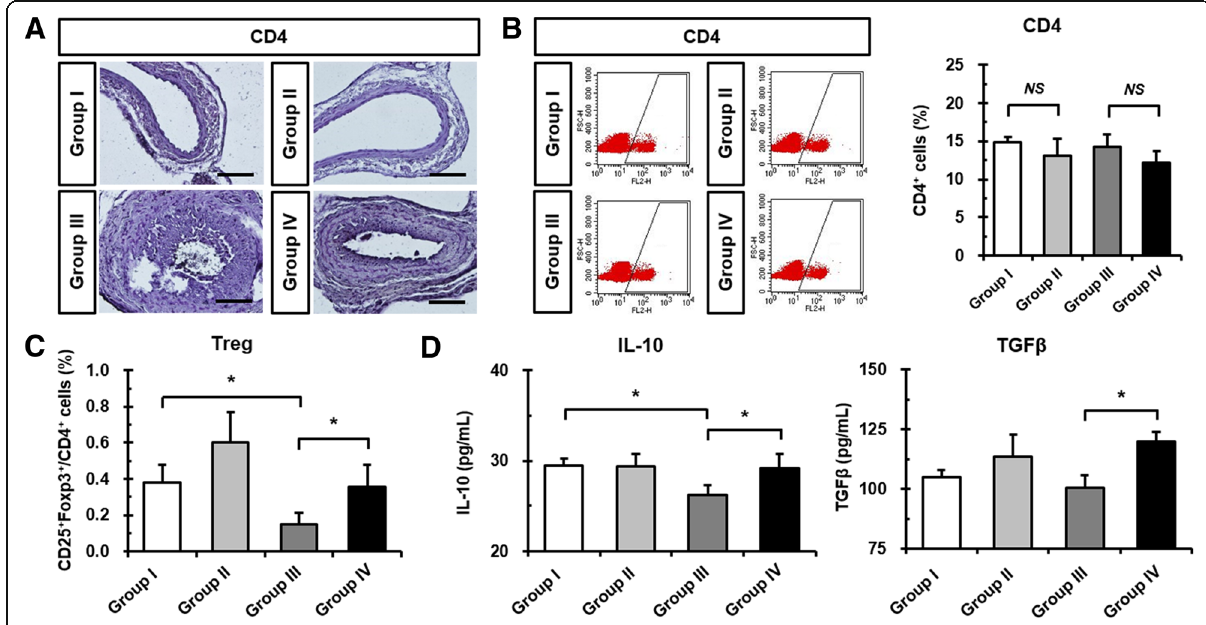
Fig. 2 Effects of Fimasartan on CD4 + T cells, Treg cells, and anti-inflammatory cytokines in the peripheral blood of ApoE KO mice. a Immunohistochemical images showing the expression of CD4 (brown) at 28days after CA injury and/or fimasartan administration. Scale bar: 100 μ m. b Representative pictures showing that CD4 + T cell subsets were gated using flow cytometry. The numbers indicate positive percentages of CD4 + T cells. c Results of statistical analyses of Treg cells in peripheral blood at 28days after CA injury and/or fimasartan administration. d Plasma levels of Treg-related cytokines, including IL- 10 and TGF β were measured by ELISA. All experimental data are from n =12 of ApoE KO mice in each group. The values are presented as the mean±SD. * p <0.05. NS , not